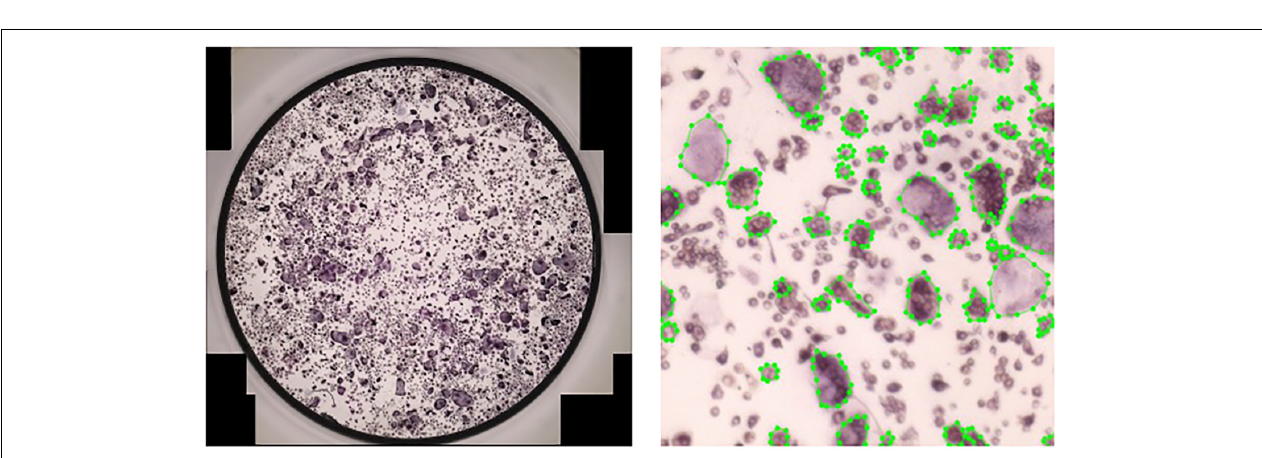
procedure. Here, we sampled 3,600,000 random patches from 10 wells used for